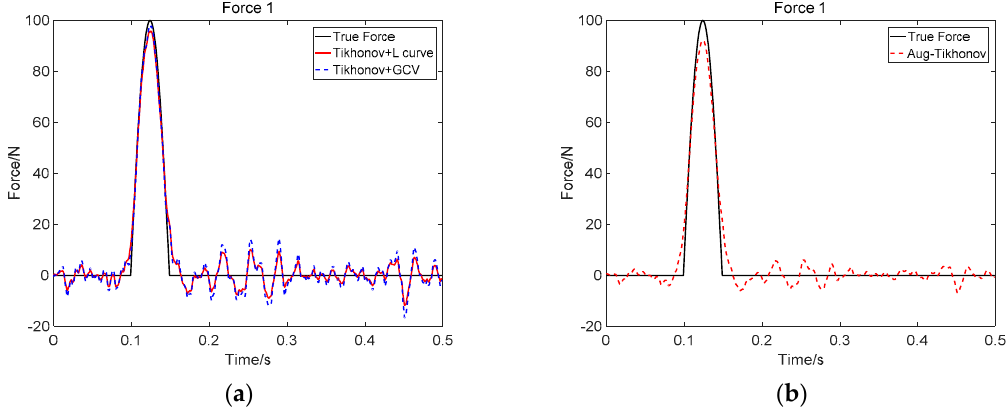
Figure 19. Identification result of two impact loads at SNR 40 dB (Force 2): ( a ) Tikhonov method; ( b ) the proposed method.